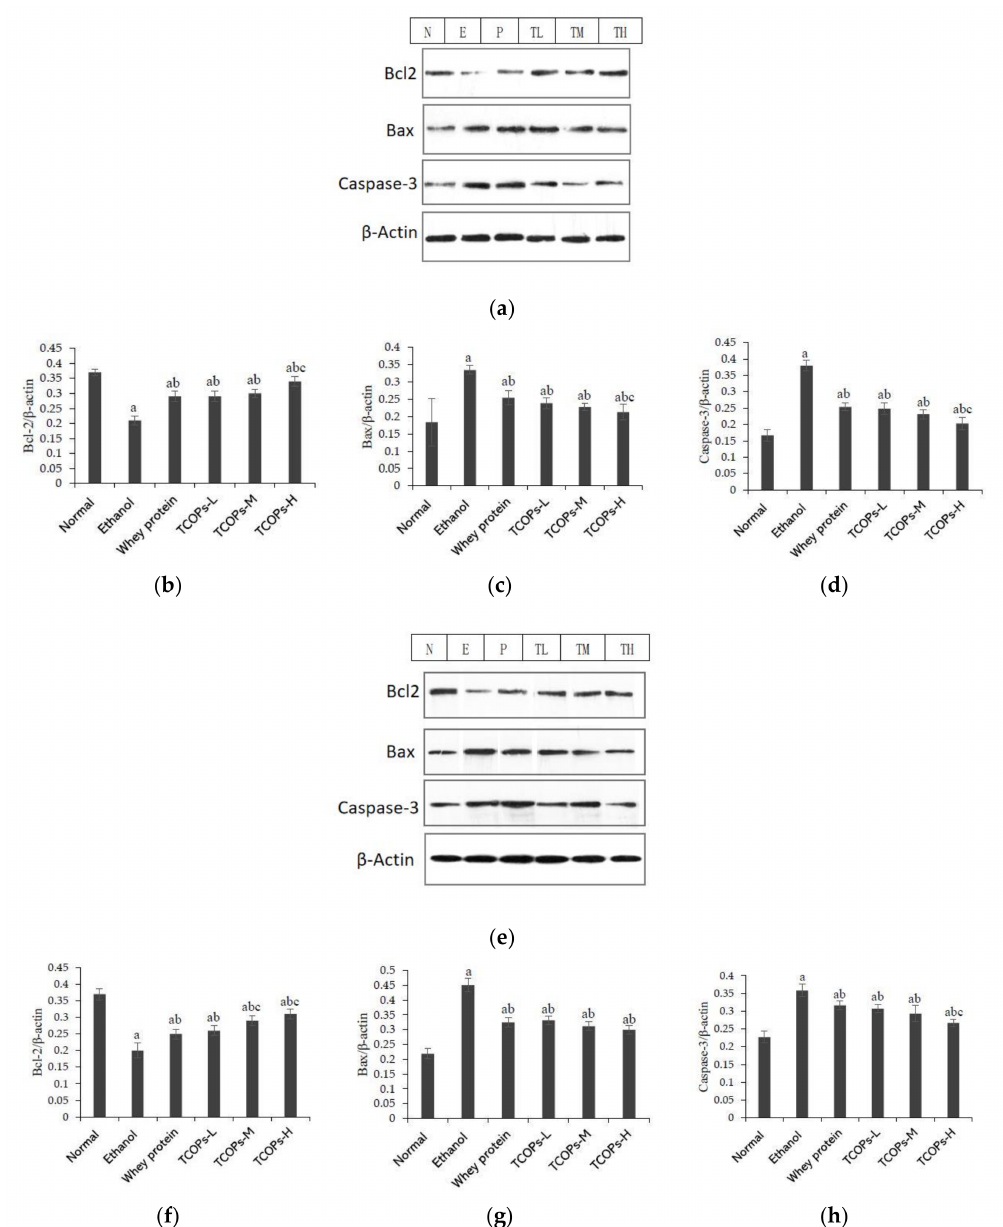
Figure 3. Effect of TCOPs on the expression of apoptosis-related proteins in gastrointestinal tissue of rats. ( a ) Effect of TCOPs on the expression of apoptosis-related proteins in gastric tissue of rats; ( b ) the expression of Bcl-2 in gastric tissue of rats; ( c ) the expression of Bax in gastric tissue of rats; ( d ) the expression of Caspase-3 in gastric tissue of rats; ( e ) effect of TCOPs on the expression of apoptosis-related proteins in duodenal tissue of rats; ( f ) the expression of Bcl-2 in duodenal tissue of rats; ( g ) the expression of Bax in duodenal tissue of rats; ( h ) the expression of Caspase-3 in duodenal tissue of rats. a: means compared with the normal control group, p < 0.05; b: means compared with the alcohol group, p < 0.05; c: means compared with the whey protein group, p <